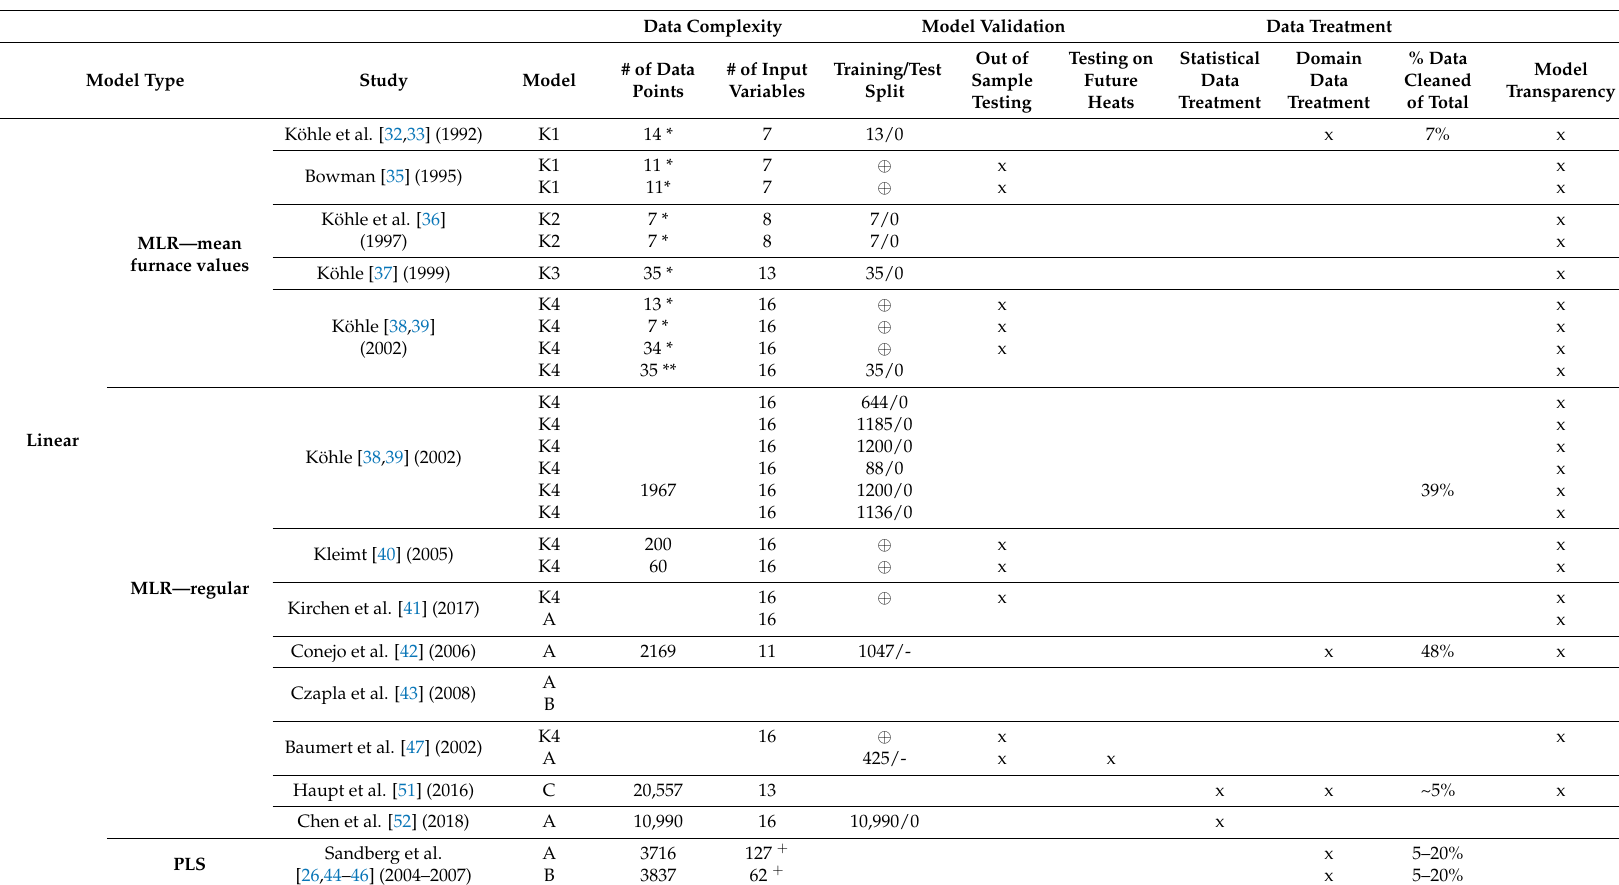
Table 5. Modeling procedures for models reported in the literature. Each entry represents a new model or new heats applied to a pre-existing model. Blank entries means either unclear information or that the modeling step was not commenced. Specifications are marked and explained further. * Average of each furnace. ** Monthly average. + Calculated from reference. ++ Complementary details from [48]. ⊕ Not applicable due to applying new data to already trained